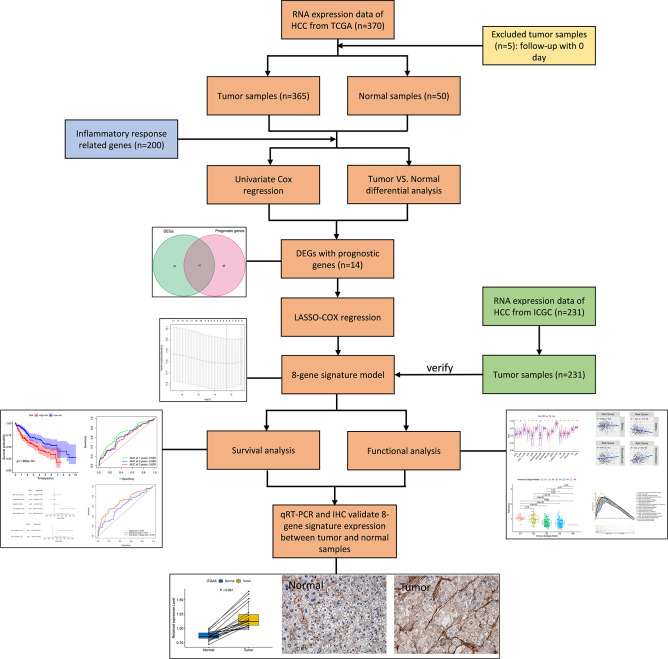
Flow chart of data collection, analysis and experiment.